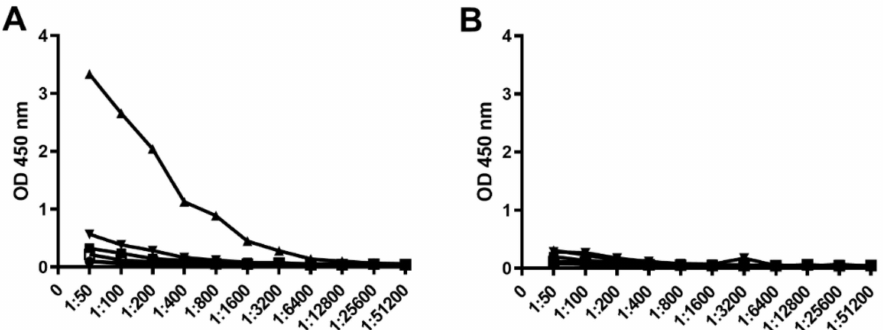
Figure 4. ELISA of BSA conjugated peptide / glycopeptide antigens with C. di ffi cile anti-spore ( A ) and C. di ffi cile anti-vegetative cell ( B ) polyclonal serum. Coating antigens are indicated as